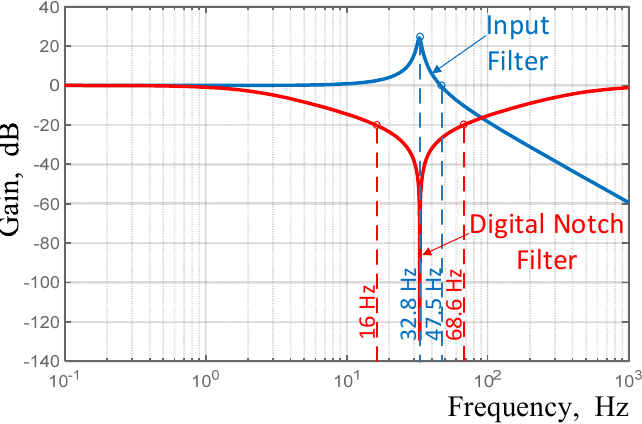
Figure 8. Transfer characteristics of the input power filter and digital notch filter plotted against the same frequency range.